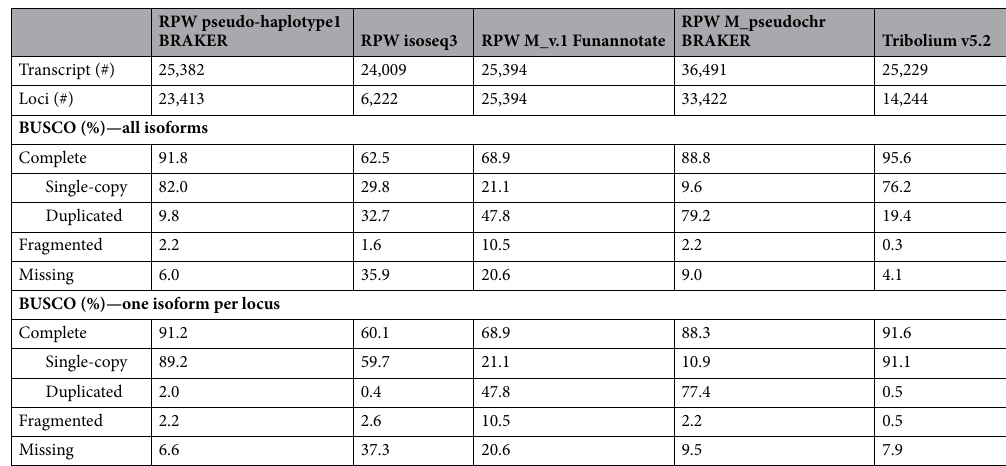
Table 2. Statistics and BUSCO scores for RPW and Tribolium annotation gene